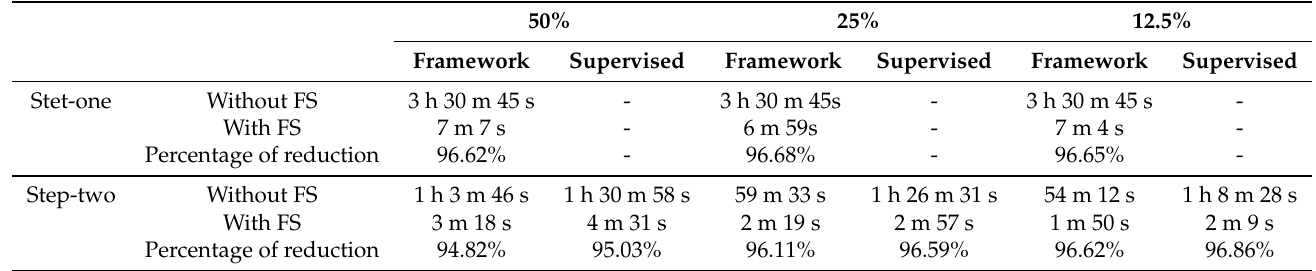
Table 6. Comparison of the training time for networks with and without FS.